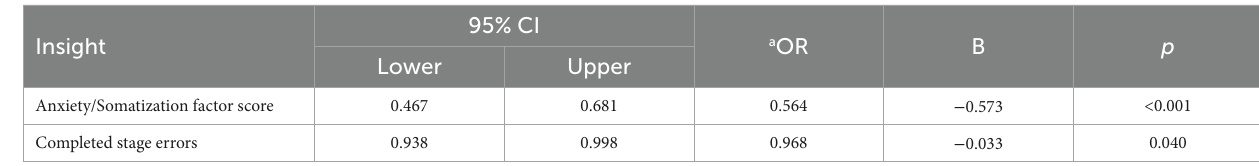
TABLE 2 Correlative factors of insight in binary logistic regression model.